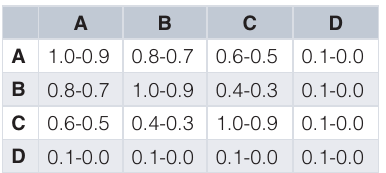
Table 2. Similarity relationships in a model data set.